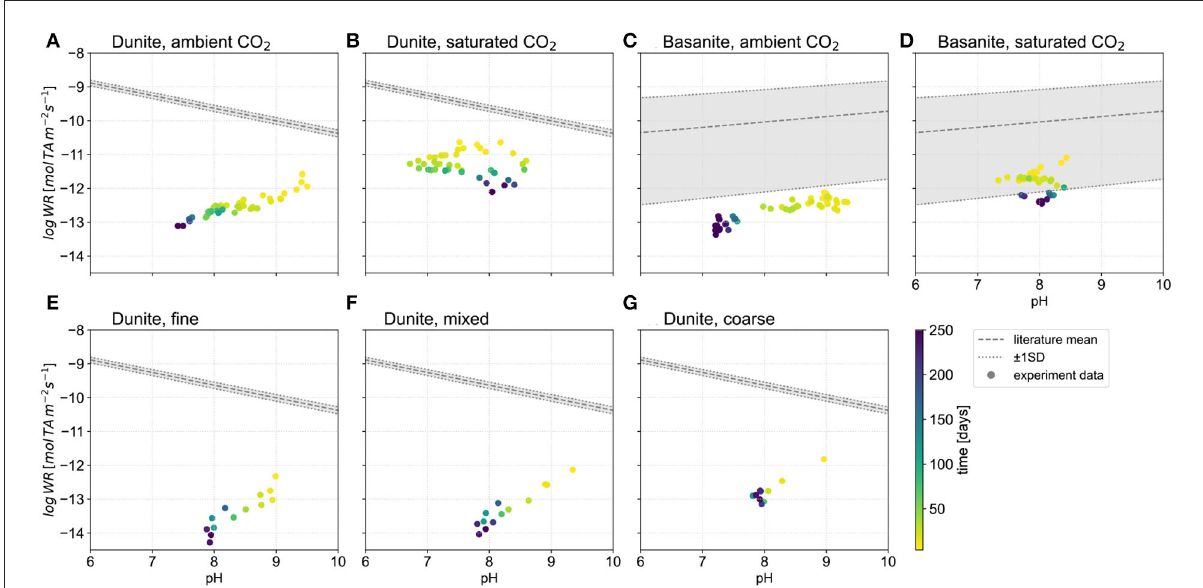
FIGURE8 TA based weathering rates plotted against pH. Fitted data for literature weathering rates (gray area and dashed lines) from Bandstra and Brantley (2008); rate values were recalculated with a stoichiometric factor to get TA to release rates. Four moles TA are produced from one mole forsterite (Equation 9). Rates for basalt are reported as mol Si m-2 s-1; here, the conversion to TA release rates is based on a generalized basalt composition (from Navarre-Sitchler and Brantley, 2007), where the equivalent of one mole Si yields 2.5 moles TA. Gradient colors indicate elapsed time of the experiment. Note that in configurations e.g., there are more rate values available, yet no corresponding pH values were recorded. (A) Dunite, ambient CO 2 , (B) Dunite, saturated CO 2 , (C) Basanite, ambient CO 2 , (D) Basanite, saturated CO 2 , (E) Dunite, fine, (F) Dunite, mixed, (G) Dunite,